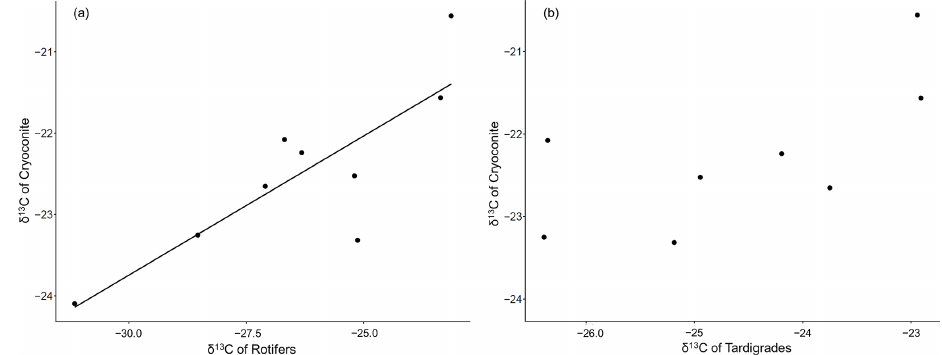
Figure 2. Correlation between decarbonized cryoconite and (a) δ 13 C of rotifers with the linear regression line and (b) tardigrades.